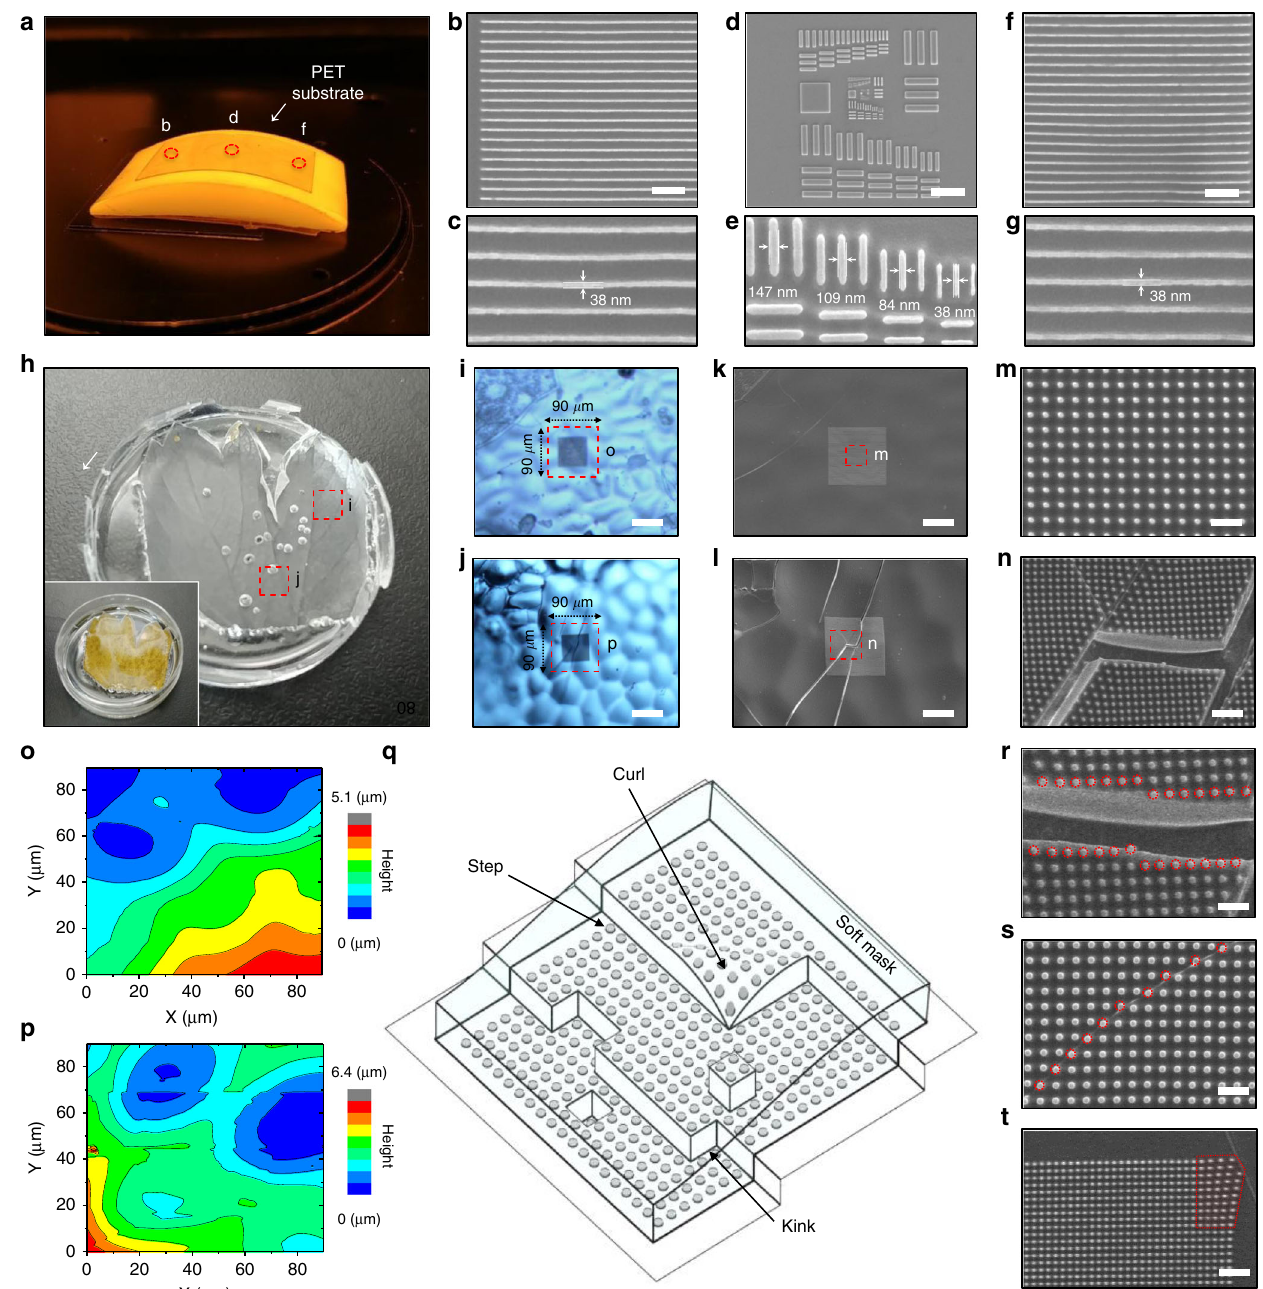
Fig. 5 Soft photomask resolves curved, rough and defect surfaces. a Photograph of PET substrate on a curvilinear Te fl on surface. b – g SEM images of the photoresist patterns at the three points ( b , d , f ) indicated in ( a ). The upper panel images show images with lower magni fi cation, and the lower panel images with higher magni fi cation. Scale bars: 1 μ m for ( b , f ), 5 μ m for ( d ). h Photograph of leaf-shaped PDMS as a substrate. The inset shows a photograph of a real leaf that was used as molding template. i, j Optical microscopy images of photoresist features on the parts of the substrate indicated with red dotted rectangles in exhibiting continuous ( i ) and discrete ( j ) surfaces. Scale bars: 50 μ m. k – n SEM images of photoresist dot pattern on the continuous ( k ) and discrete ( l ) surfaces. m, n Show magni fi ed images of ( k ) and ( l ), respectively, of the part of the surface as indicated by red dotted rectangles. Scale bars: 25 μ m for ( k , l ), 1 μ m for ( m ), 2 μ m for ( n ). o , p AFM images of the continuous ( o ) and discrete ( p ) parts of the surfaces as indicated by red dotted rectangles in ( i , j ). q Schematic illustration of a soft substrate on a surface with step, curl and kink defects. r – t SEM images of photoresist dot feature at kink ( r ), step ( s ) and curl ( t ) on a surface. Scale bars: 1 μ m for ( r , s ), 2 μ m for ( t